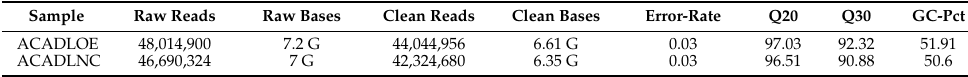
Table 2. Raw data and quality control data of each sample